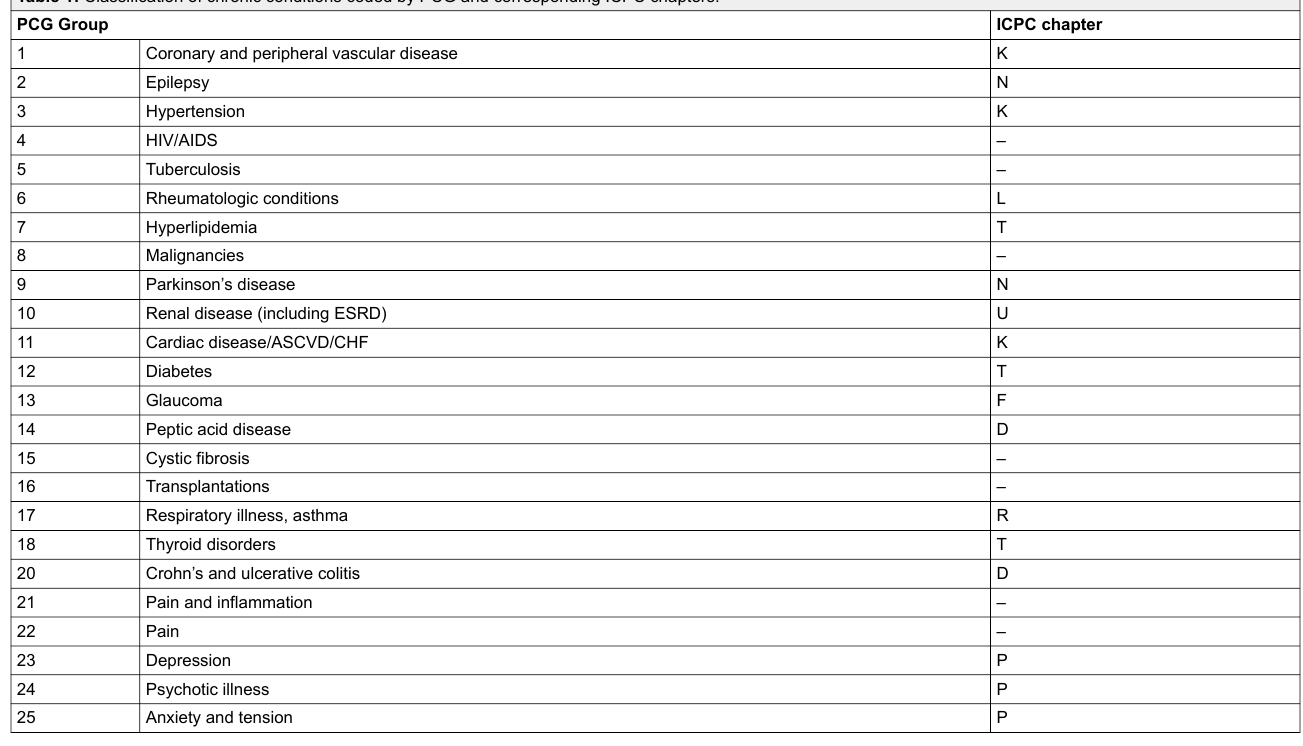
Table 1: Classification of chronic conditions coded by PCG and corresponding ICPC chapters.